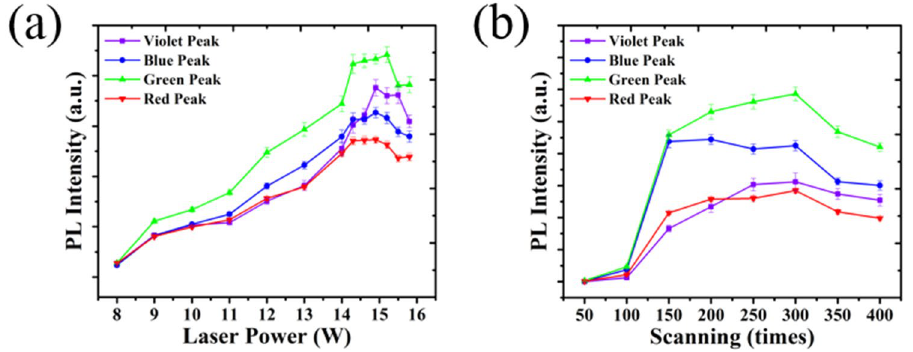
Figure 5. Intensity dependence of the four deconvoluted peaks on ( a ) the laser power intensity and ( b ) the number of